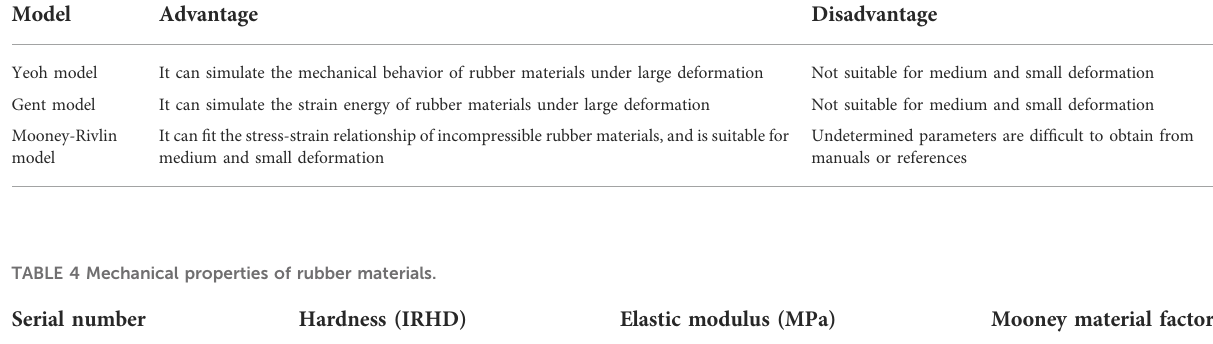
TABLE 3 Comparison of different constitutive models.